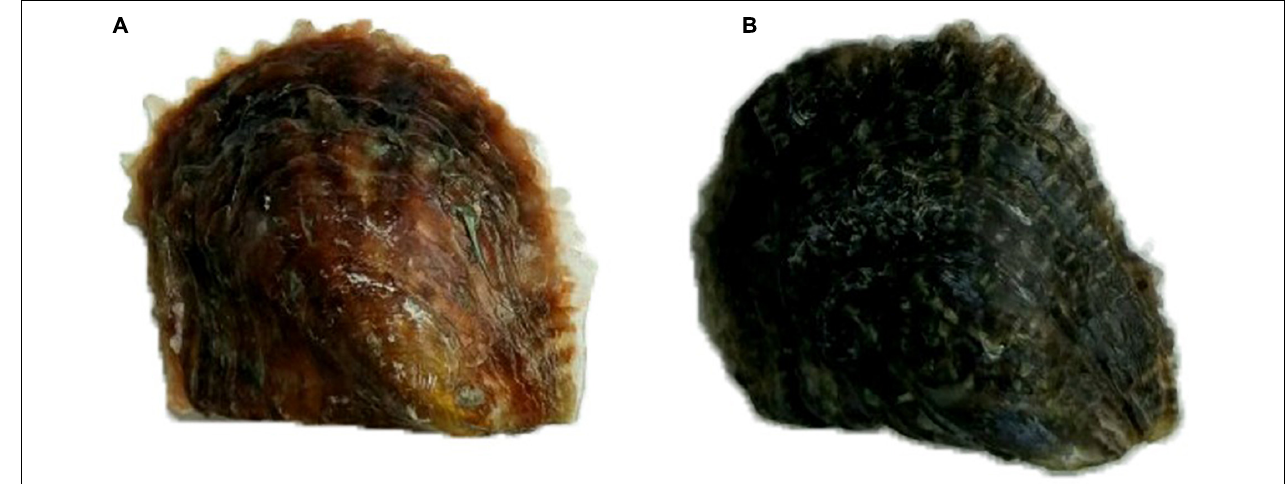
FIGURE 1 | (A) Red shell; (B) Black shell.